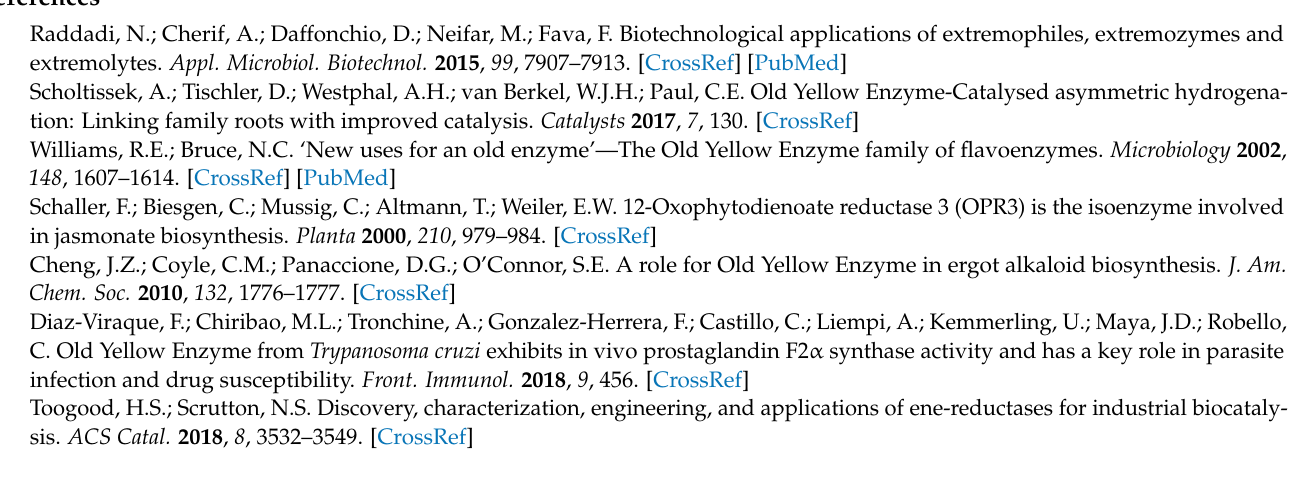
Figure S3: Plot of FMN cofactor interactions in the active site of holo enzyme Ca OYE, Table S1: Oligonucleotides used for PCR amplification of Ca OYE sequences and cloning, Table S2: X-ray crystallographic data collection and refinement statistics for Ca OYE, Table S3: List of OYE